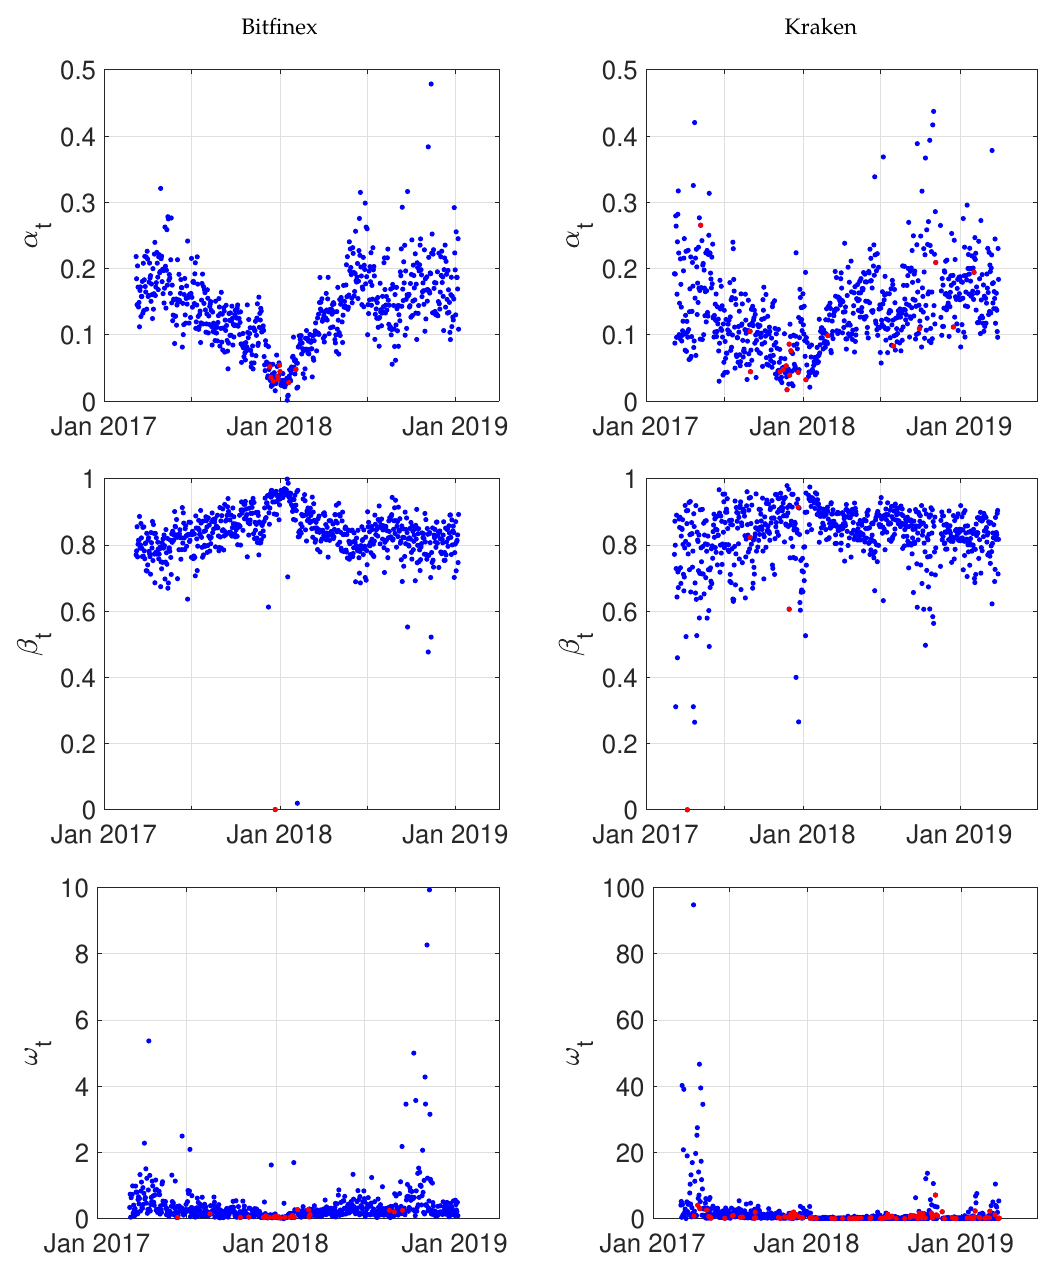
Figure 7. Time series of parameter estimates. Note. The figure presents the time series of the daily QML parameter estimates for the EACD(1,1) model. Blue (red) points indicate that the estimate is (not) statistically significant on a 5% significance level. The graphics on the left refer to Bitfinex, on the right to